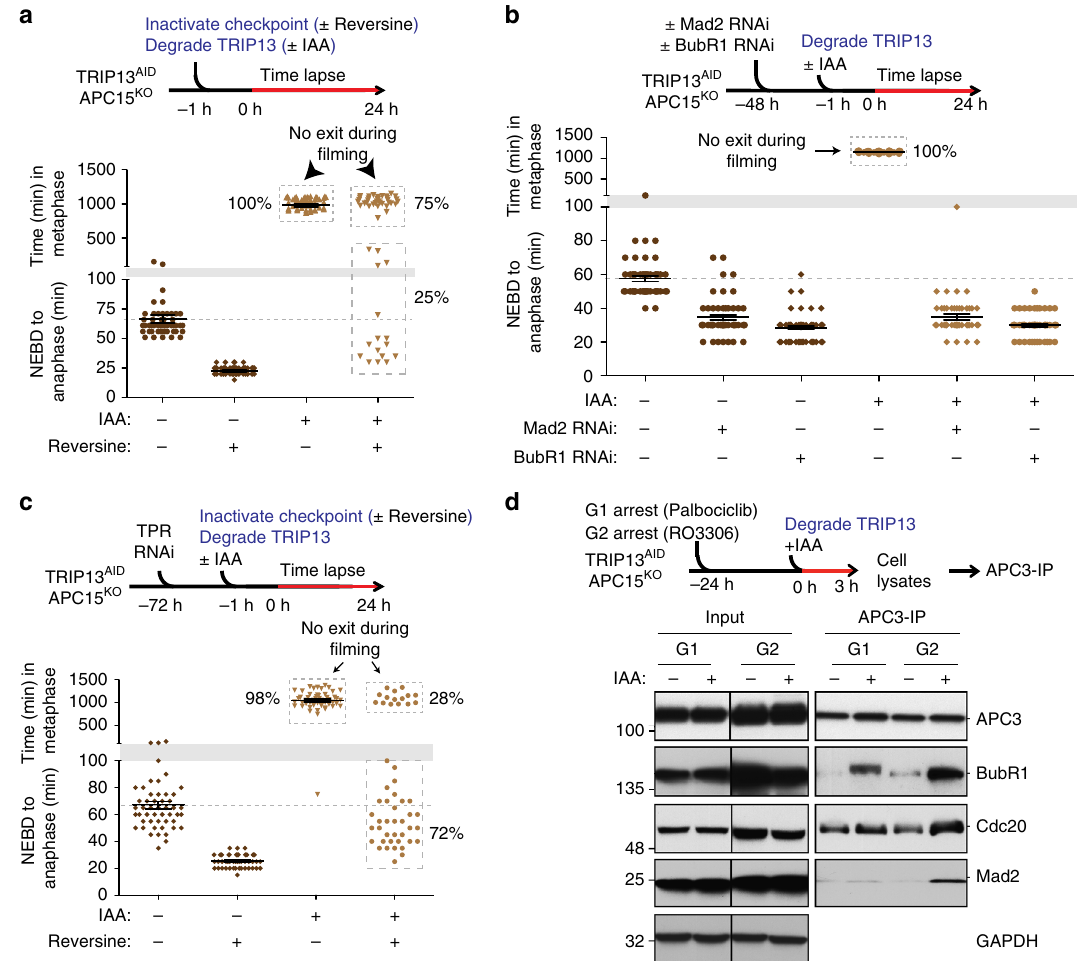
Fig. 4 TRIP13 and APC15 are required for turnover of MCC produced in interphase. a Upper: Schematic of experiment to measure the dependence of the observed mitotic exit delay on kinetochore-catalyzed MCC production. Lower: mitotic timing in reversine-treated TRIP13 AID /APC15 KO cells in the presence or absence of IAA. ( n = 50 for each experimental condition). b Upper: Schematic of experiment to measure the dependence of the observed mitotic exit delay on Mad2 and BubR1. Lower: mitotic timing in Mad2 or BubR1 RNAi treated TRIP13 AID /APC15 KO cells in the presence or absence of IAA. ( n = 50 for each experimental condition). c Upper: Schematic of experiment to measure the dependence of the observed mitotic exit delay on Tpr. Lower: mitotic timing in Tpr RNAi treated TRIP13 AID /APC15 KO cells in the presence or absence of reversine and IAA. ( n = 50 for each experimental condition). d Upper: Schematic of experiment to measure APC/C MCC formation in TRIP13 AID /APC15 KO . APC3 was immunoprecipitated from cells in G1 with Palbociclib and in late G2 with RO-3306. Lower: APC/C interacting BubR1 and Cdc20 levels were measured by quantitative immunoblotting. Lines in a – c represent the mean ±